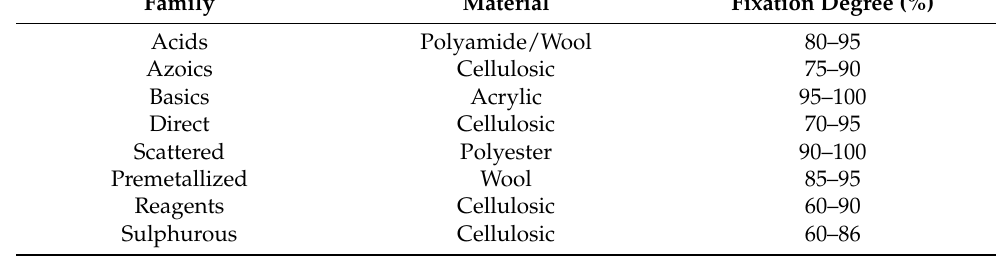
Table 1. Fixation percentages of different families of colorants and their estimated loss in effluents [20].